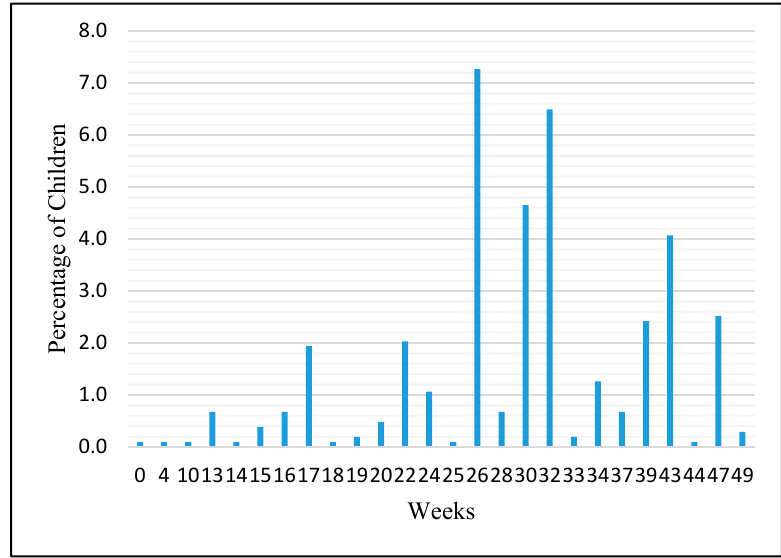
Figure 2. Introduction of sugar sweetened beverage (SSB) by infant age in weeks.